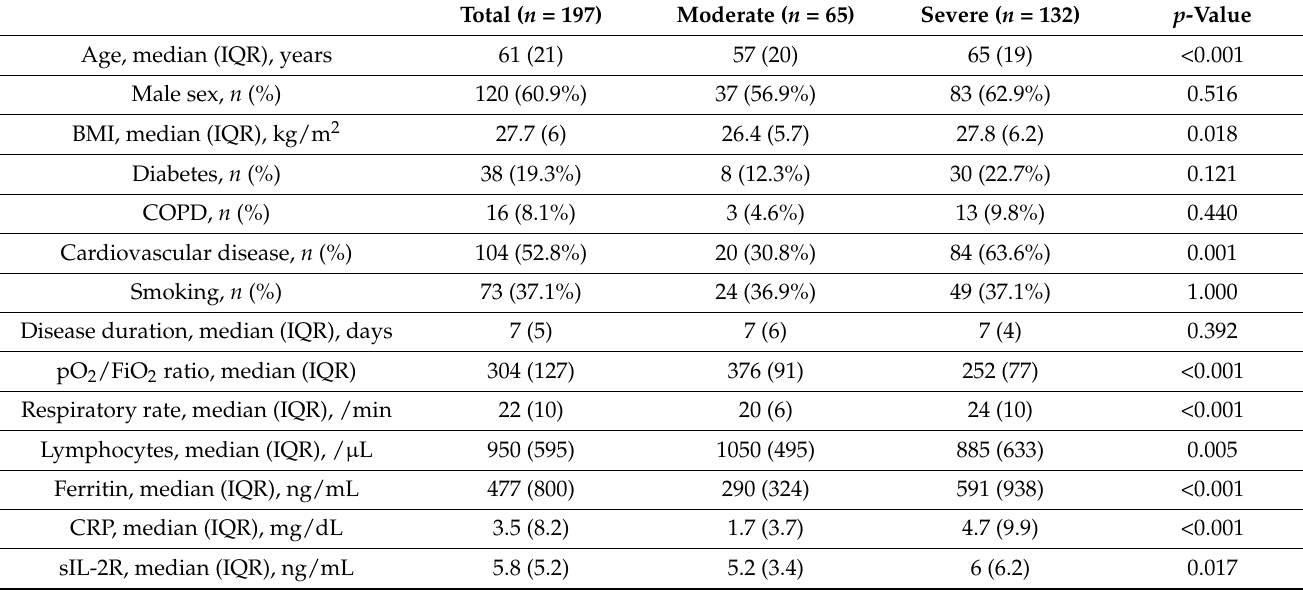
Table 1. Baseline characteristics according to disease